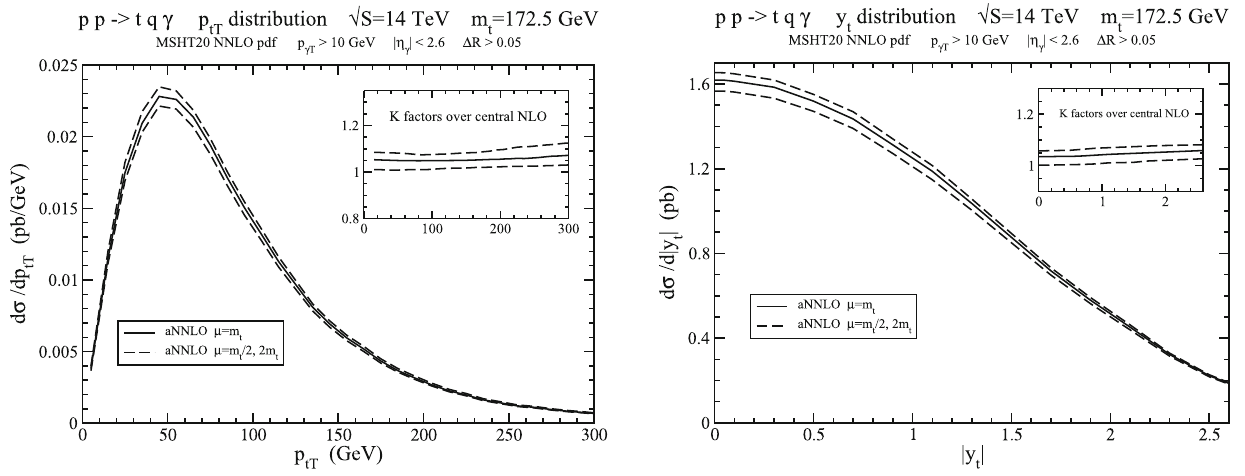
Fig. 9 The aNNLO top-quark p T (left) and rapidity (right) distributions in tq γ production at 14 TeV LHC